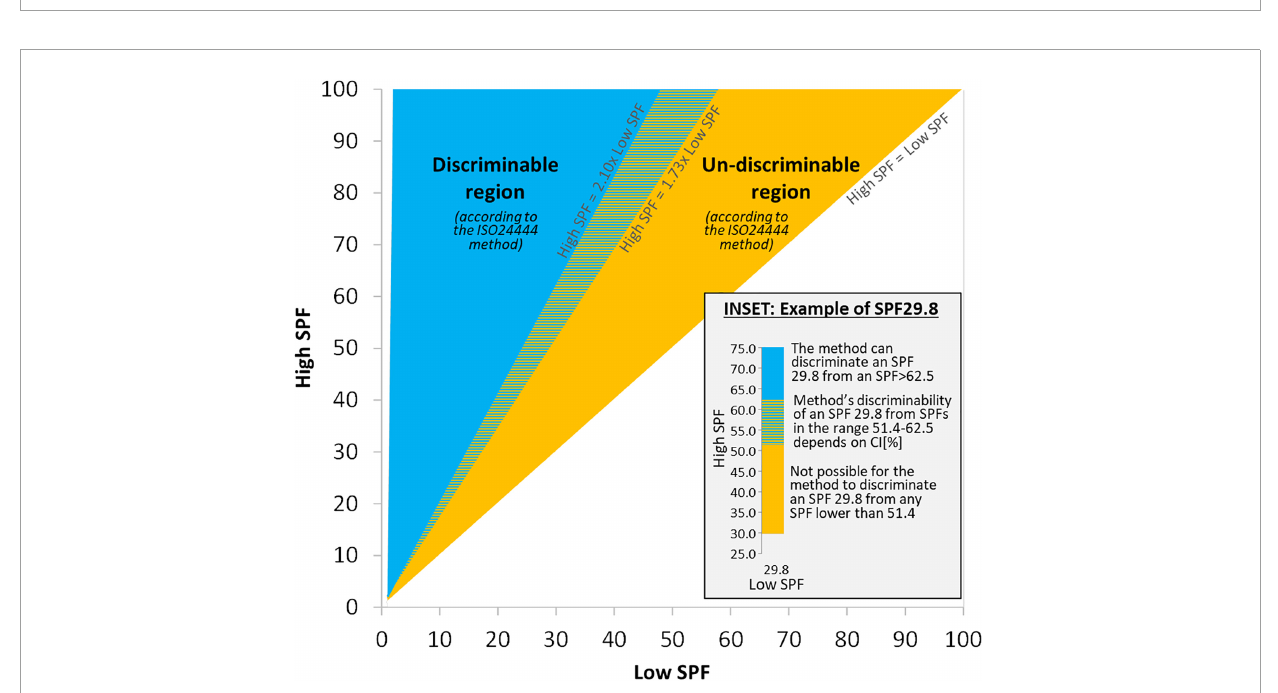
FIGURE2 Discriminability map: Map showing the regions where the ISO method can/cannot discriminate between SPF results from two independent ISO-valid tests for the same product (a “High SPF” and a “Low SPF” test, with n = 10 each). Inset details a case of Low SPF result of 29.8, which could be labeled as SPF 25, 30, or 50 in the EU due to method’s